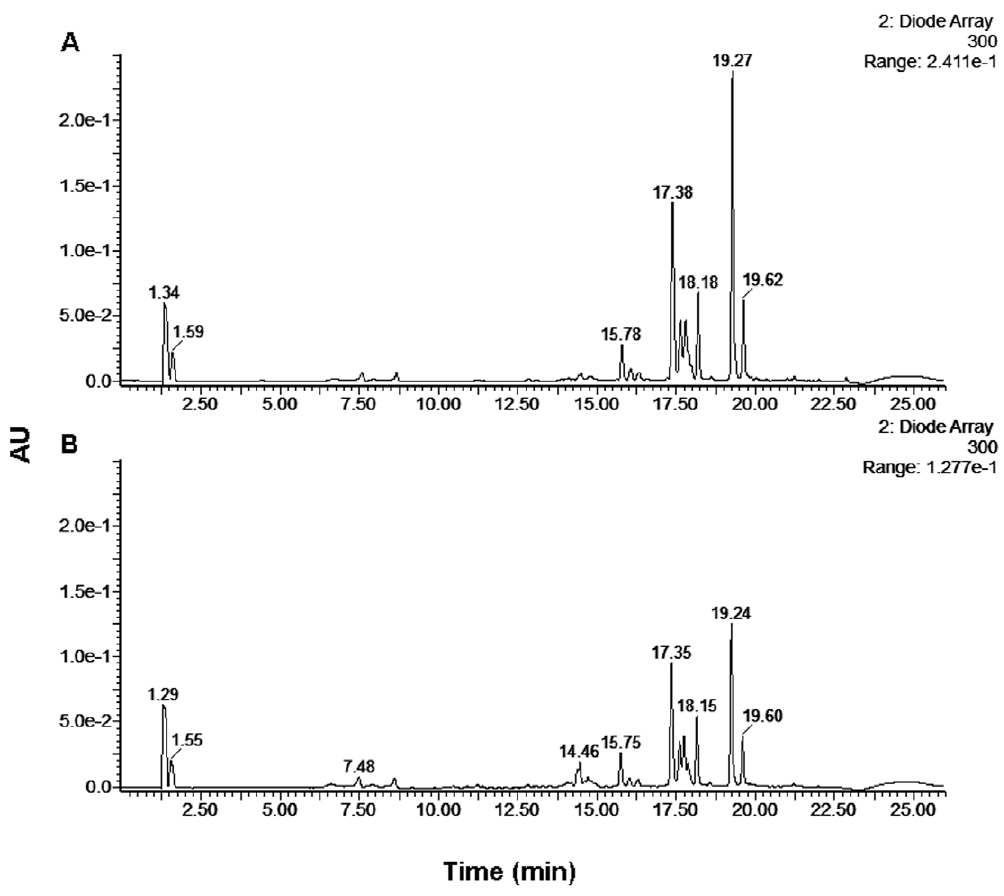
Figure 7. LC-DAD (300 nm) chromatogram of the phenolic compounds in the incubation medium before (A) and after (B) 2 h of exposure of the yeast S.cerevisiae to eluate EL70 (1%). AU, arbitrary units. model G1312A binary pump and a model G1330B autosampler (Agilent Technologies). This reversed-phase HPLC separation was carried out using a Gemini C18 column (150 mm 6 2.0 mm internal diameter; 3 m m particle size), which was protected by a Gemini C18 security guard cartridge (4.0 mm 6 2.0 mm internal diameter) (Phenomenex). The mobile phase comprised aqueous